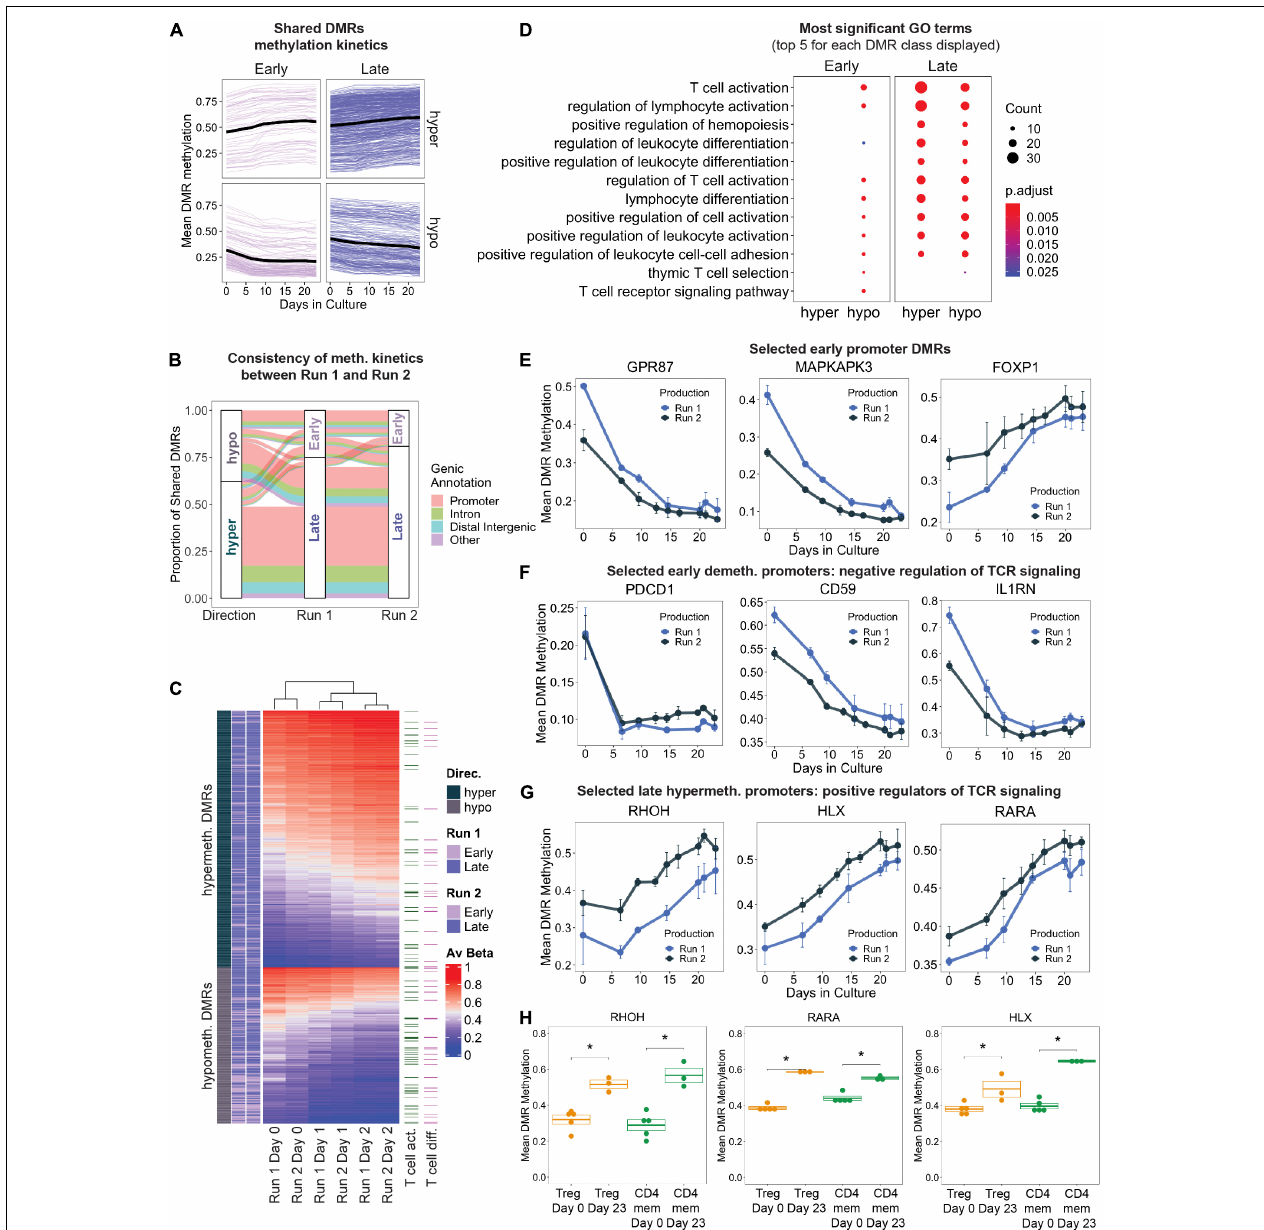
FIGURE 3 | (A) Change in mean DMR methylation of shared DMRs over the 23 days of in vitro expansion. Early DMRs were defined as being significantly differentially methylated in day 10 – day 0 (and remained significant in day 23 – day 0), and Late DMRs were only significantly differentially methylated at day 23 – day 0. Each line displays one DMR, bold black line displays the mean. (B) Display of all shared DMRs according to their directionality of methylation change (hyper/hypo) and to their Early/Late classification (as in A ) in production Run1 and 2. Color code indicates genic annotation of the DMR. (C) Unsupervised hierarchical clustering of shared DMRs in both production runs, with DMRs mapping to genes implicated in T cell activation and T cell differentiation (GO terms 0042110 and 0030217) highlighted. (D) Gene ontology enrichment analysis of shared DMRs that were consistently “Early” or “Late” between both production runs, stratified by directionality. The top 5 GO terms (ranked by adjusted p -value) for each DMR class are represented, many of which overlap. Size of dots indicates number of genes associated with GO term, and color indicates adjusted p -value. (E–G) Level of DNA methylation on selected DMRs in known T cell genes. (H) DNA methylation at the promoters of RHOH , HLX , and RARA in FACS-sorted Tregs and memory CD4 + T cells (CD4mem) before (Day 0) and after frequent CD3/CD28 stimulation (Day 23). ∗ denotes p .val < 0.05 ( T test).